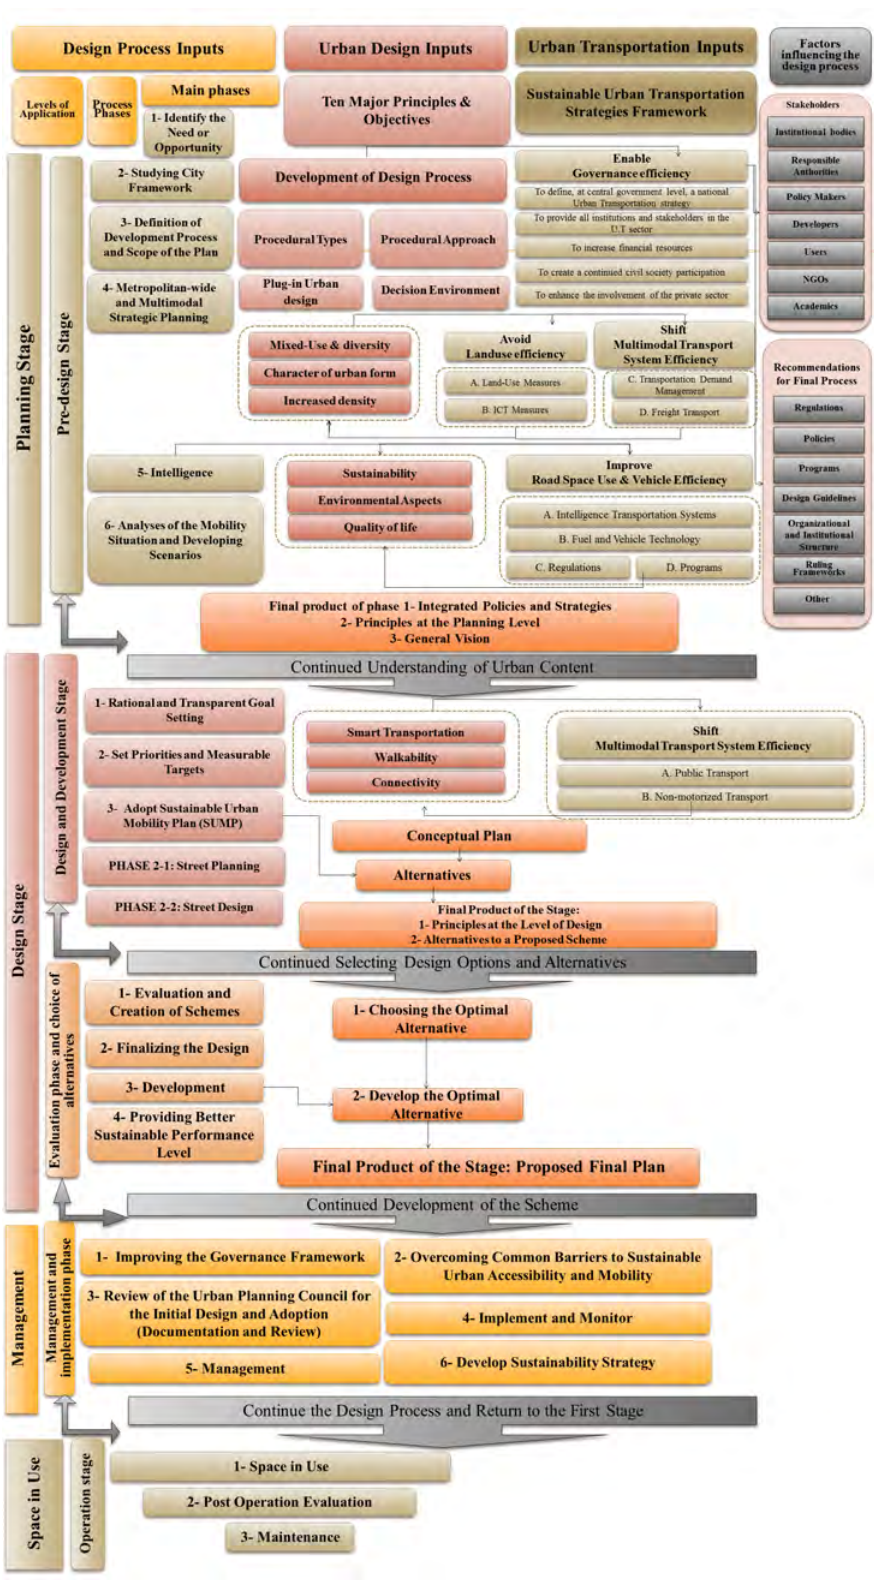
Figure 5. Final Integrated Theoretical Framework for Urban Transportation Design Process